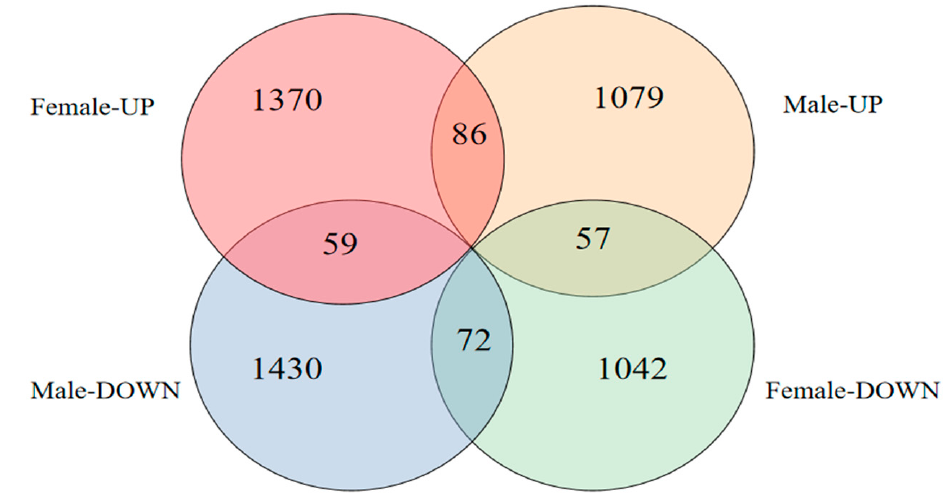
Figure 5. Number of DEGs after MT exposure.